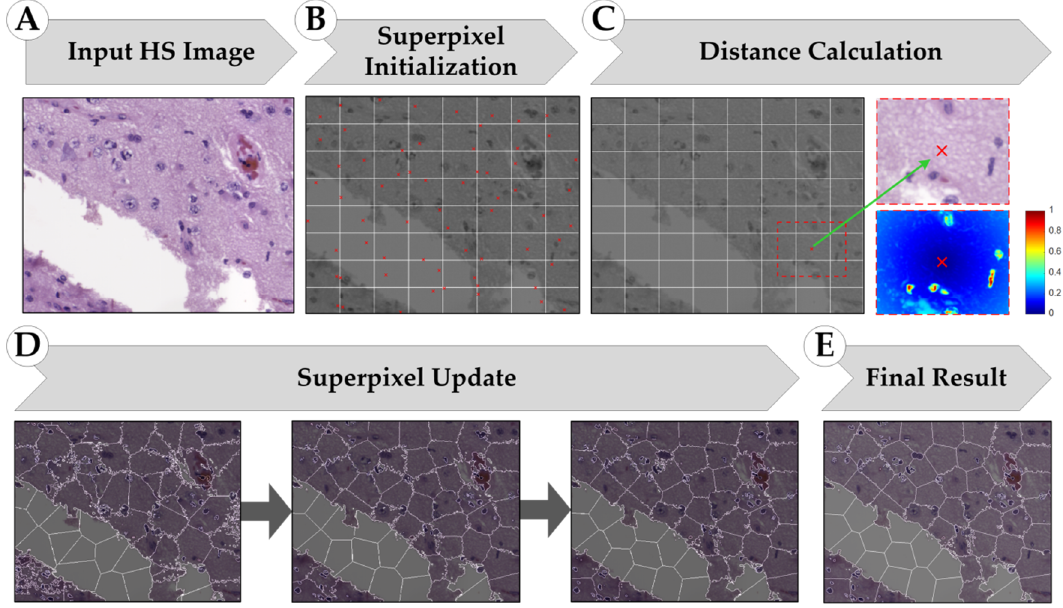
Figure 5. Block diagram of the different steps of the SLIC approach for superpixel classification.